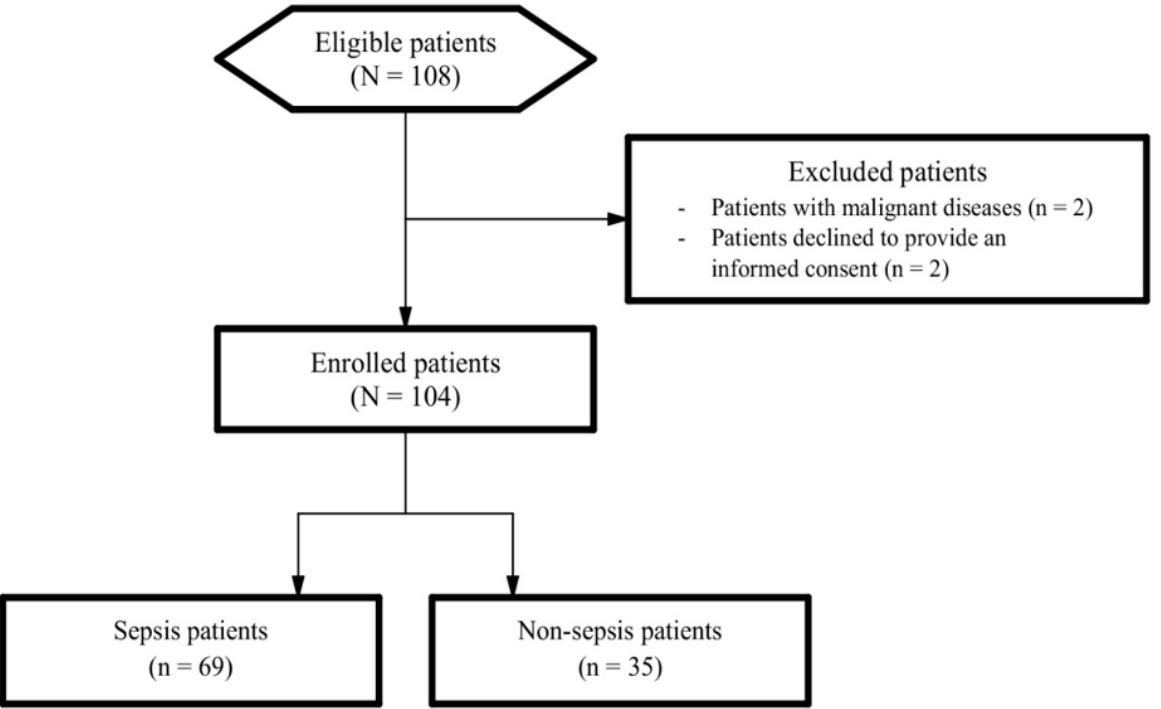
Figure 1. Flow chart of eligible and enrolled patients.